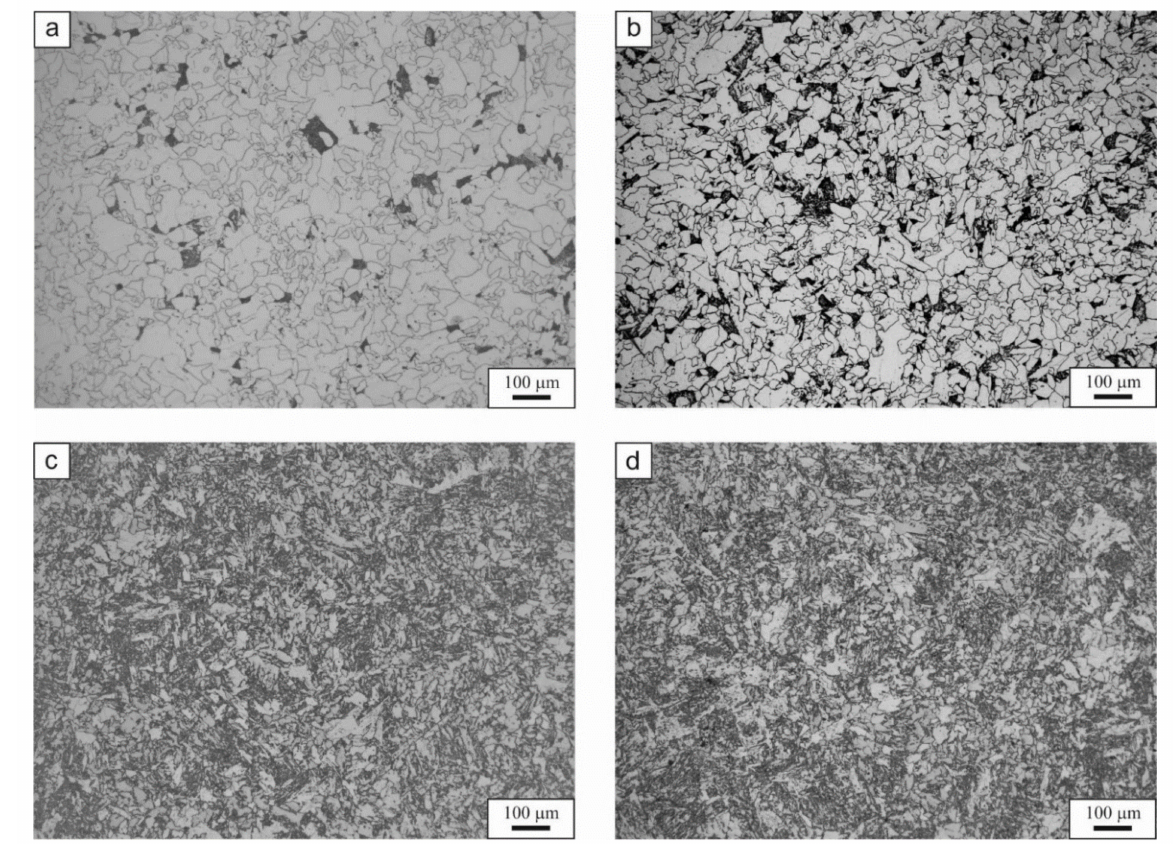
Figure 5. Light microscope micrographs of the selected variants of cooling: ( a ) 0.1 ◦ C/s, ( b ) 1 ◦ C/s, ( c ) 8 ◦ C/s, ( d ) 60 ◦